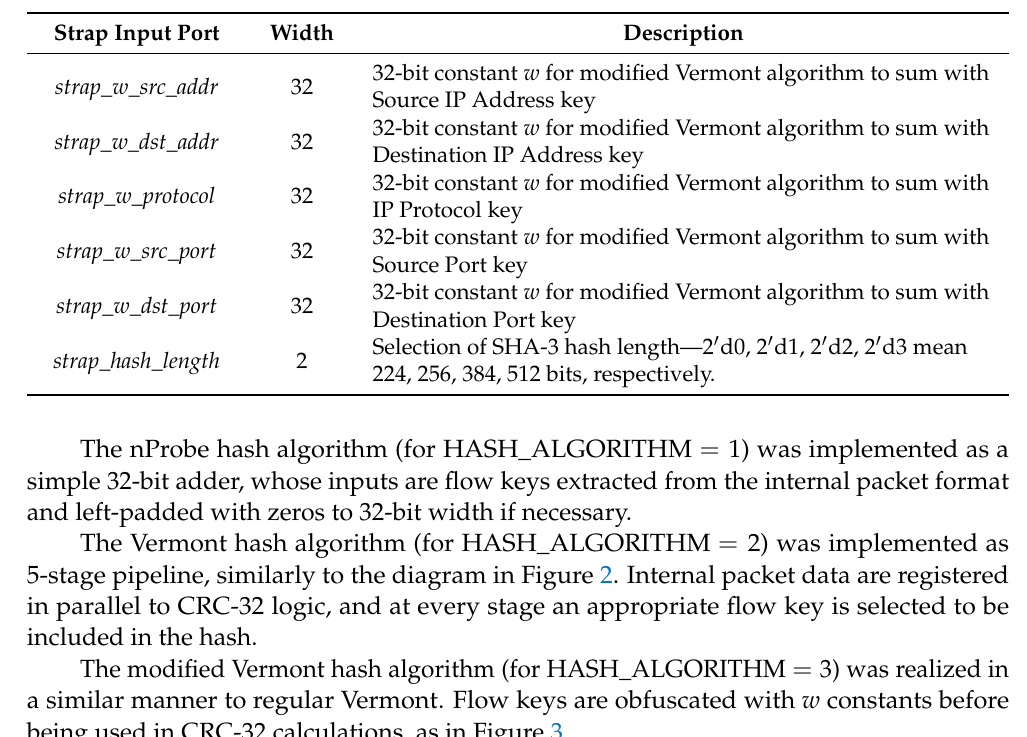
Table 4. Module netprobe_hash_top strap ports for algorithm